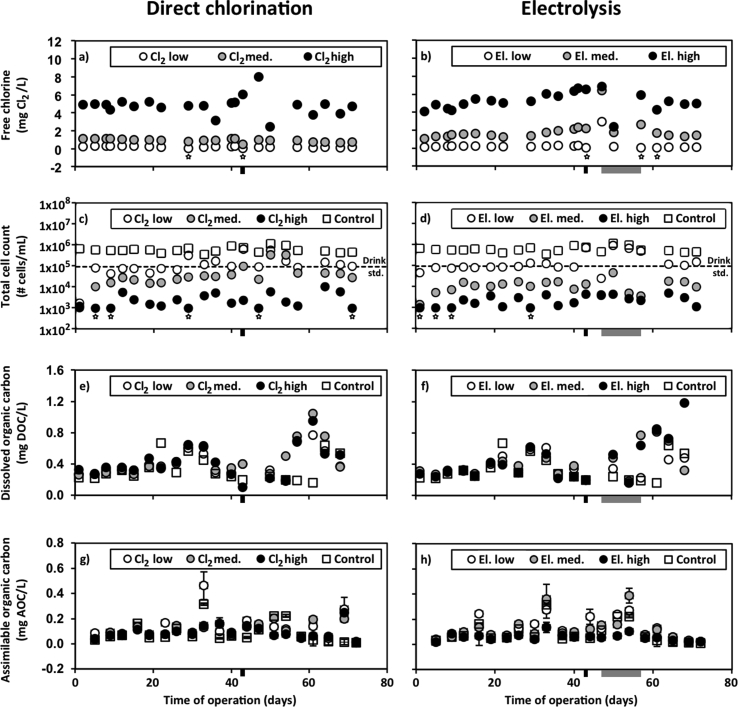
Free chlorine, total cell count (TCC), dissolved organic carbon (DOC) and assimilable organic carbon (AOC) for different dosages of direct chlorination (left plots), dosages of electrolysis (right plots) and control. The axis titles and scales are the same for horizontal pairs. All plots have the same x-axis title and scale. Measurements below quantification are plotted as the quantification limit and indicated using a star placed below the data point. Dashed lines indicate TCC of drinking water. Black bars beneath the x-axes indicate an interruption in aeration. Grey bars beneath the x-axes represent an interruption in electrolysis control.